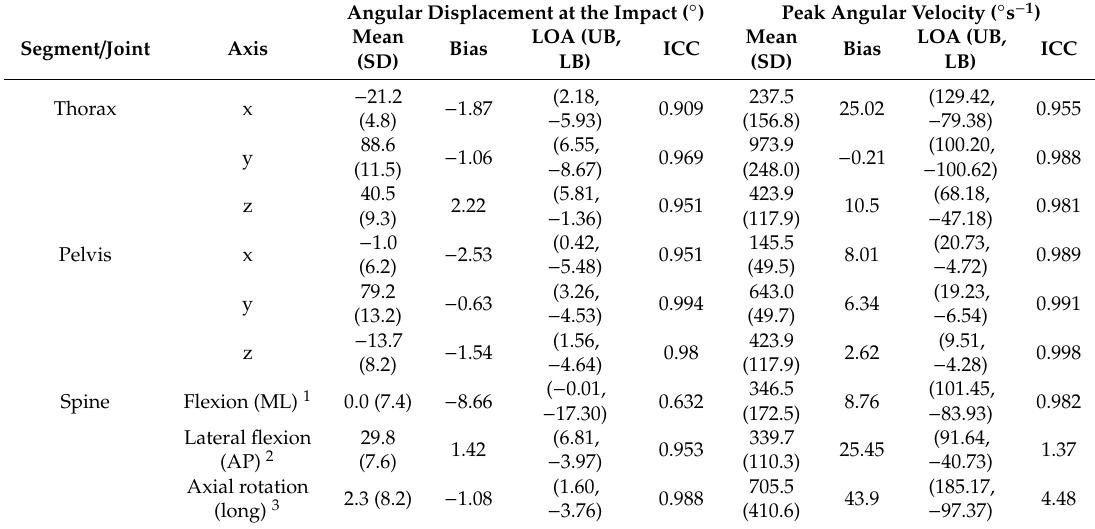
Table 2. Mean (standard deviation) measurements of IMUs, mean bias with upper and lower bound of thelimitofagreement(LOA[UB,LB]),andintra-classcorrelationcoe ffi cient(ICC)betweenmeasurement systems at impact in angular displacement (in degrees except ICC) and at peak in angular velocity (in degrees per second except ICC) of the thorax, pelvis, and